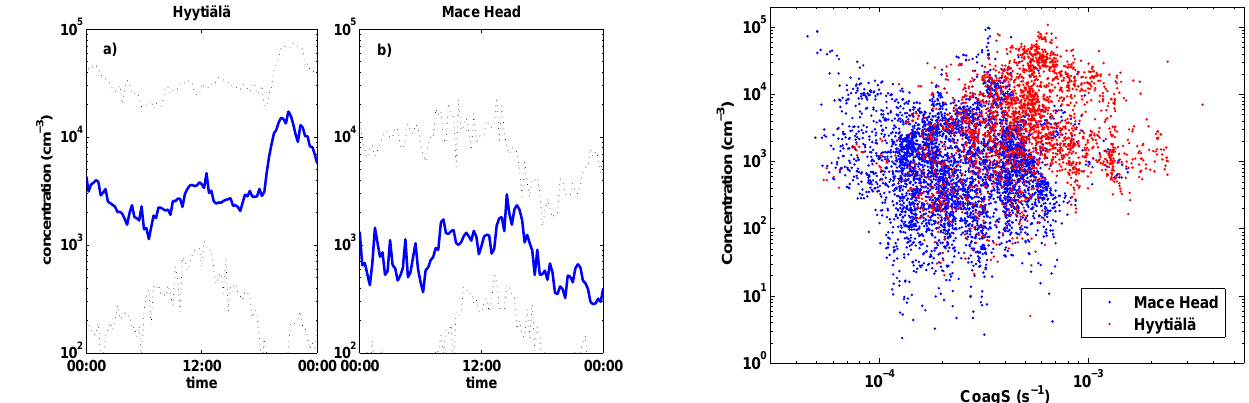
Fig. 2. The measured nano-CN concentration as a function of the coagulation sink (CoagS) calculated for 2nm particles from DMPS/SMPS